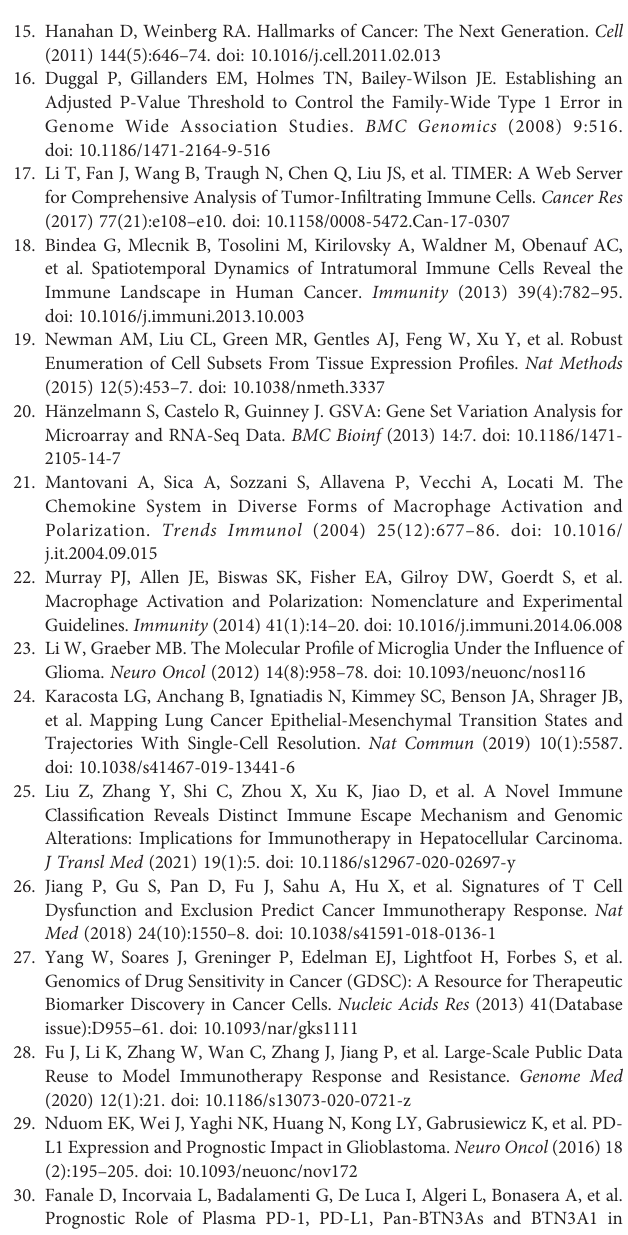
Supplementary Figure 1 | PD-L1 expression level in various cancers. (A) PD-L1 expression level in various cancers was analyzed by box-plot. (B) Correlation between PD-L1 and immune in fi ltrates in HNSCC. Supplementary Figure 2 | Scatter diagram of the correlation between PD-L1 expression and immune cell in fi ltration in OSCC. Supplementary Figure 3 | Relationship between PD-L1 and immune in fi ltrates in the GEO validation set. (A) Heat map of OSCC samples by using the ssGSEA scores from 26 immune cell types. (B) PD-L1 signi fi cantly associated with Immune cells. Scatter plot showing correlation between PD-L1 and various immune cells, including aDC (C) , M1 macrophages (D) , M2 macrophages (E) , Cytotoxic cells (F) , T cells (G) and Th1 cells (H) . Supplementary Table 1 | The Clinicopathological data of